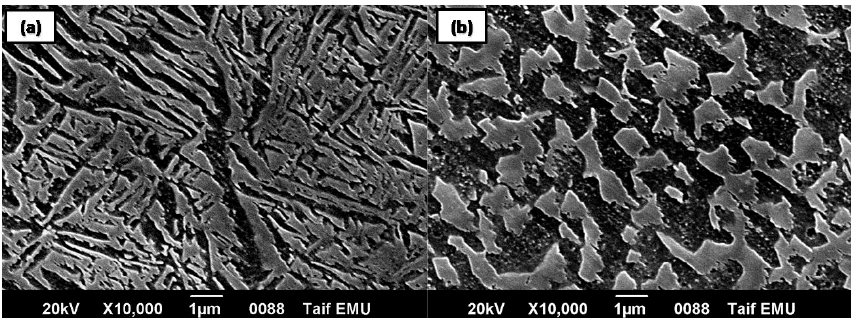
Figure 2. Morphology of β phase in TC21 alloy: ( a ) acicular-like structure; and ( b ) blocky shaped structure.